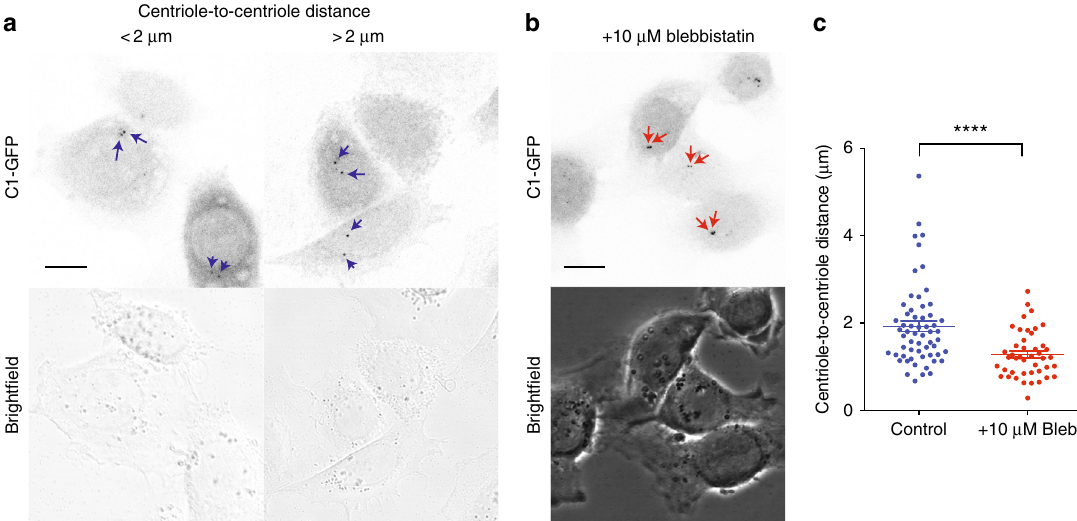
Fig. 1 Acto-myosin contractility inhibition limits centriole separation in a non-synchronous HeLa cells. a Representative pictures of untreated asynchronous HeLa cells expressing Centrin1 (C1-GFP). Blue arrows indicate pair of centrioles. Two different centriole separation behaviors have been observed: in one case (left panel) centrioles separate with distances <2 μ m; in the other case (right panel) centrioles separate further than 2 μ m, up to 6 μ m. Scale bar 10 μ m. b Inhibition of acto-myosin contractility via blebbistatin treatment signi fi cantly reduces the centriole-to-centriole distance. Red arrows indicate pair of centrioles. Scale bar 10 μ m. c Quanti fi cation of centriole-to-centriole distance in non-synchronous HeLa cells, untreated (Control) or treated with 10 μ M Blebbistatin (Bleb) (Control n = 59 cells; + 10 μ M Bleb n = 44 cells). Error bars represent s.e.m.; p -value was obtained with unpaired two-tailed t